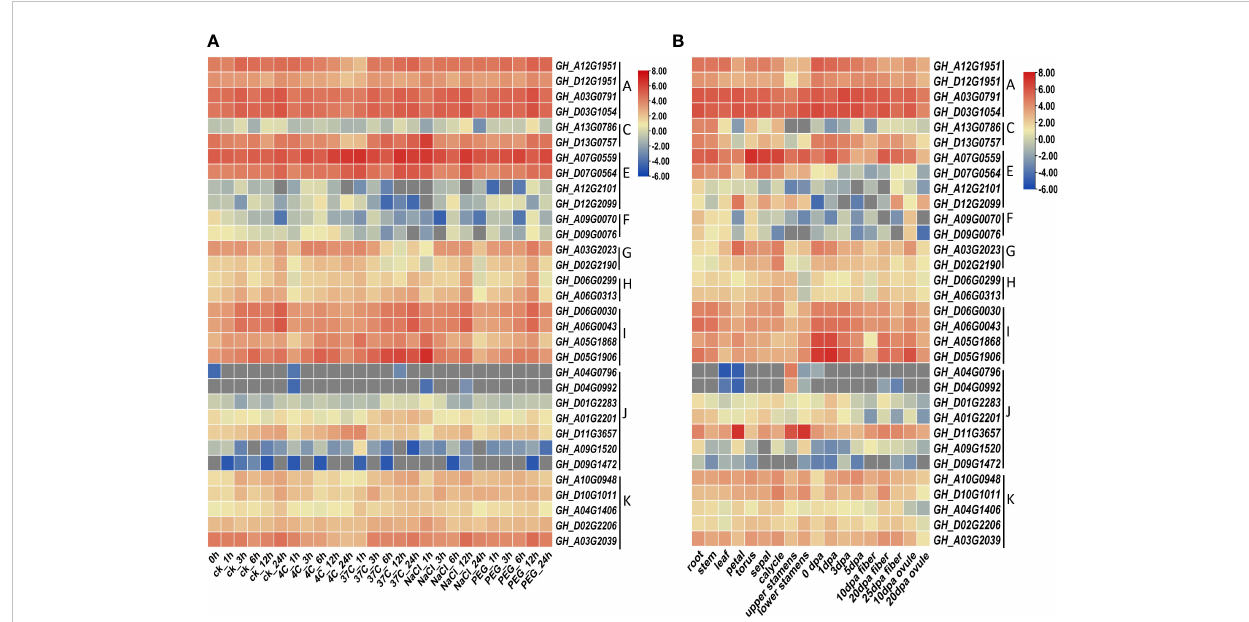
FIGURE 5 Expression pattern analysis of GhHVA22 . (A) Expression pattern analysis of GhHVA22 under control, low temperature, high temperature, salt and drought stress conditions, expressed as CK, 4°C, 37°C, 400mM NaCl and 20% PEG, respectively. (B) Analysis of the expression pattern of GhHVA22 in different organs, where 0-5 dpa represents ovules and fi bers that were not isolated for 1 – 5 days.